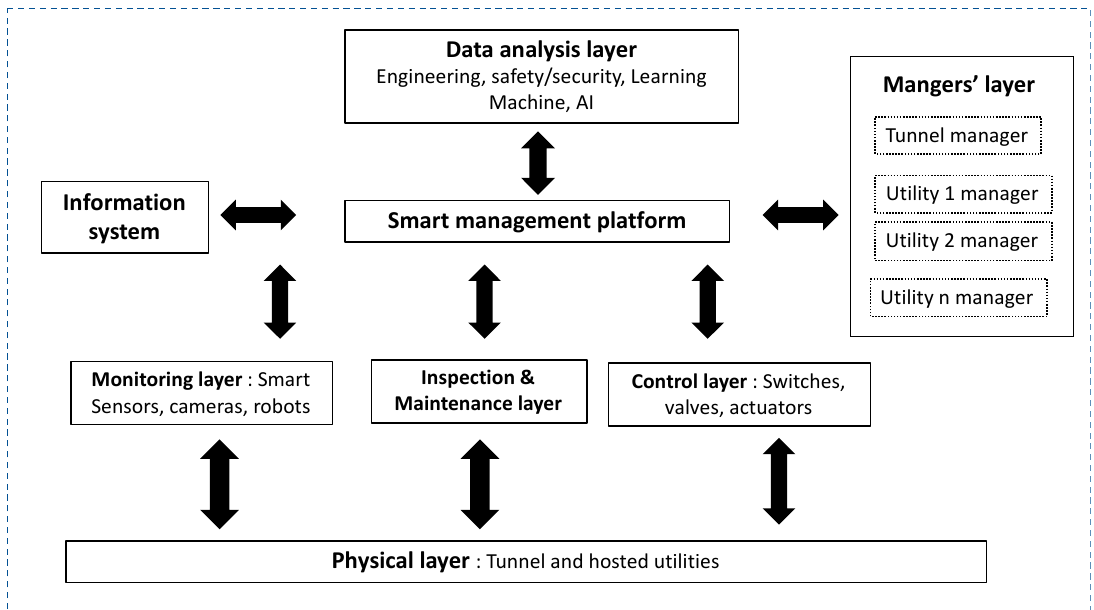
Figure 4. Architecture of the utility tunnel smart management system.